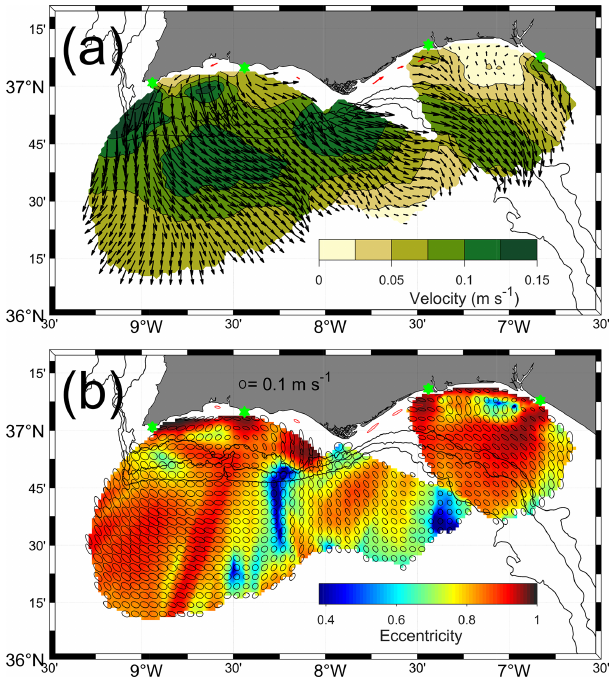
Figure 5. Mean HFR surface velocities (a) and SD ellipses and ec- centricity (b) for the period February 2016–October 2020. For clar- ity, the ellipses and arrows are represented every three grid nodes. The mean velocity and SD ellipses of ADCP data for the deploy- ment periods and stations indicated in Fig. 2 are shown in red. The locations of the HFR antennas are indicated with green